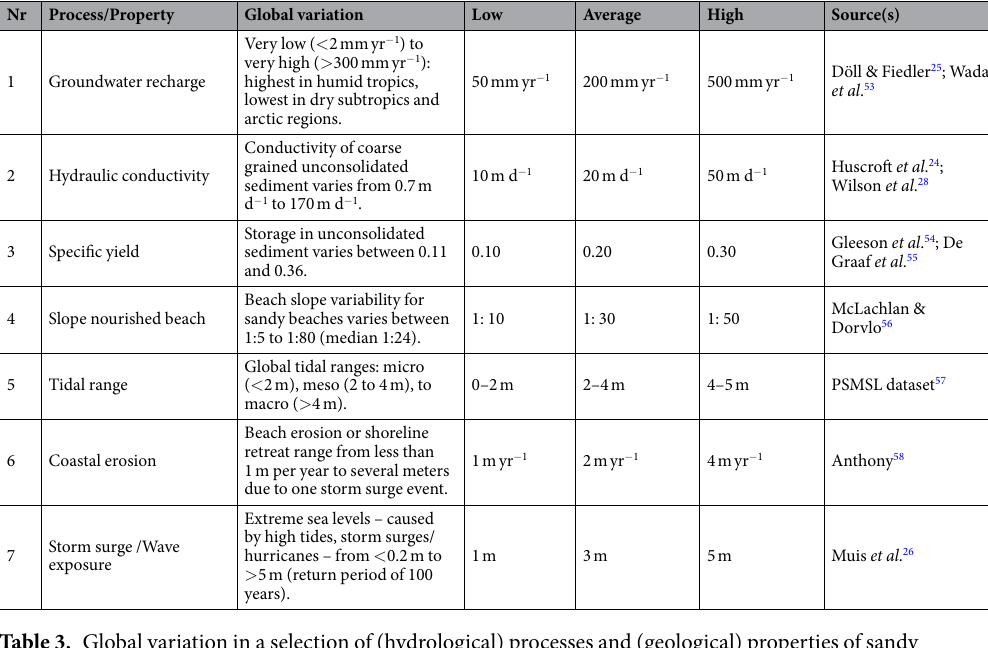
Table 3. Global variation in a selection of (hydrological) processes and (geological) properties of sandy beaches. The impact of each factor on fresh groundwater resources was evaluated with common estimates of low, average and high values within the noted limits.